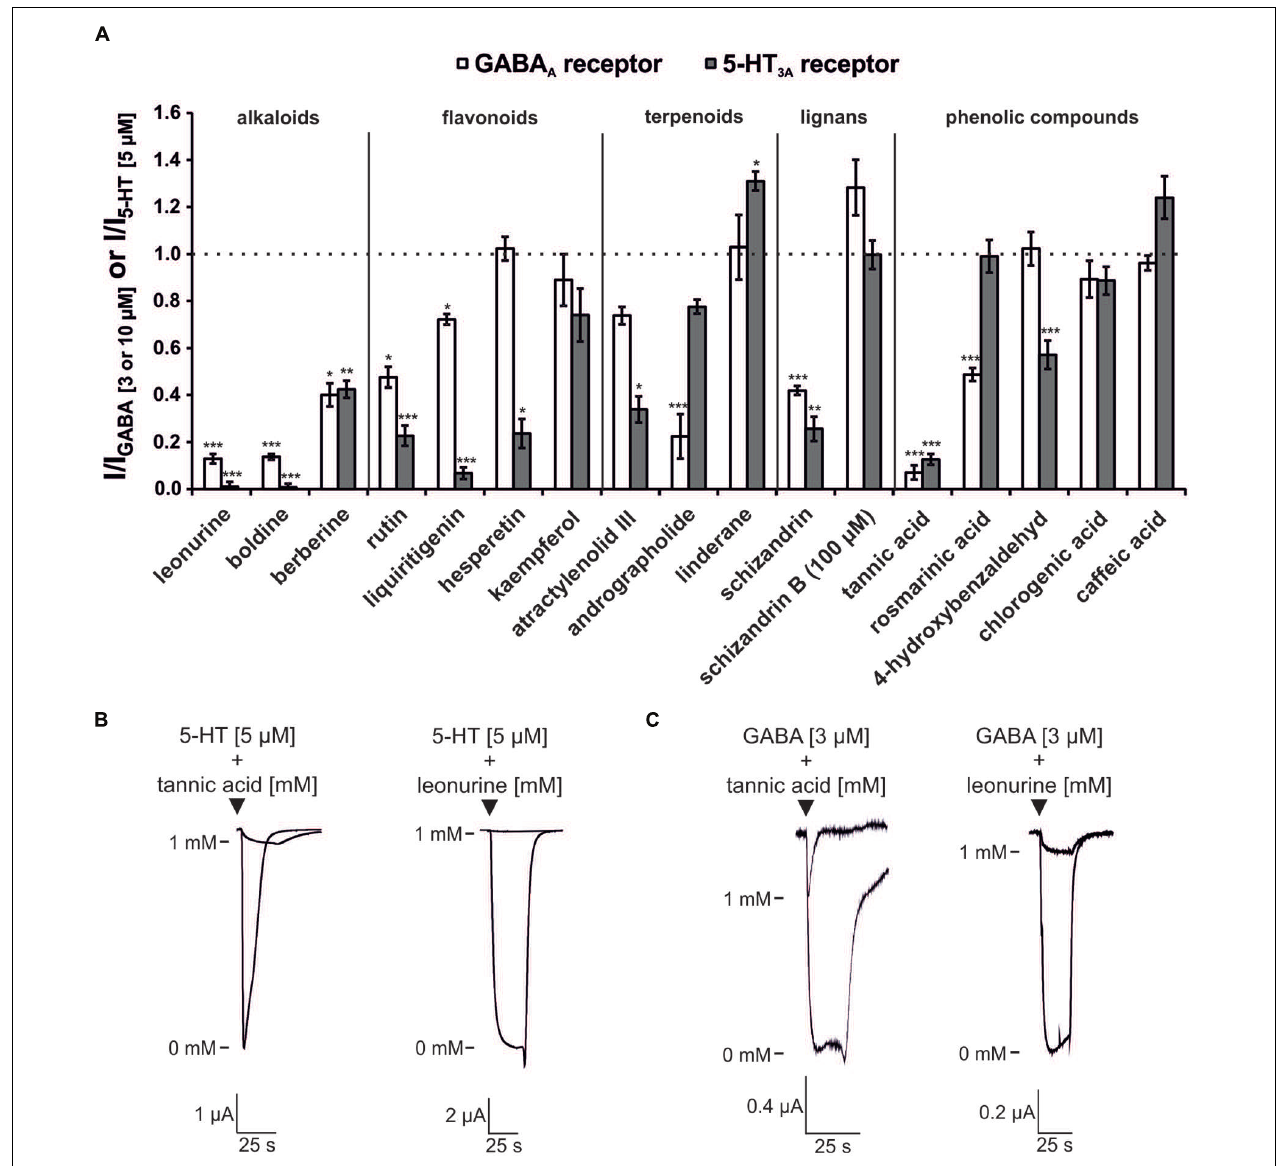
FIGURE 4 | Modulatory effects of the investigated ingredients on the 5-HT 3A and GABA A receptors. (A) The bars represent the normalized current amplitude for the modulation of the 5-HT 3A (gray bars) and GABA A (white bars) receptors. With the exception of schizandrin B, which was tested at 100 µ M, all of the compounds were evaluated at a concentration of 1 mM. Bars exceeding the dotted line represent substances with potentiating effects. The substances are arranged based on their affiliation to classes of plant metabolites, as indicated by the vertical lines. Statistical differences were calculated based on the reference agonist, which contained an equal concentration of the solvent used to dissolve the test compounds ( ∗ p < 0.05, ∗∗ p < 0.005, ∗∗∗ p < 0.0005; n = 4–7). (B) Original registrations of the inhibition of the 5-HT 3A receptor by tannic acid and leonurine. (C) Original registrations of the inhibition of the GABA A receptor by tannic acid and